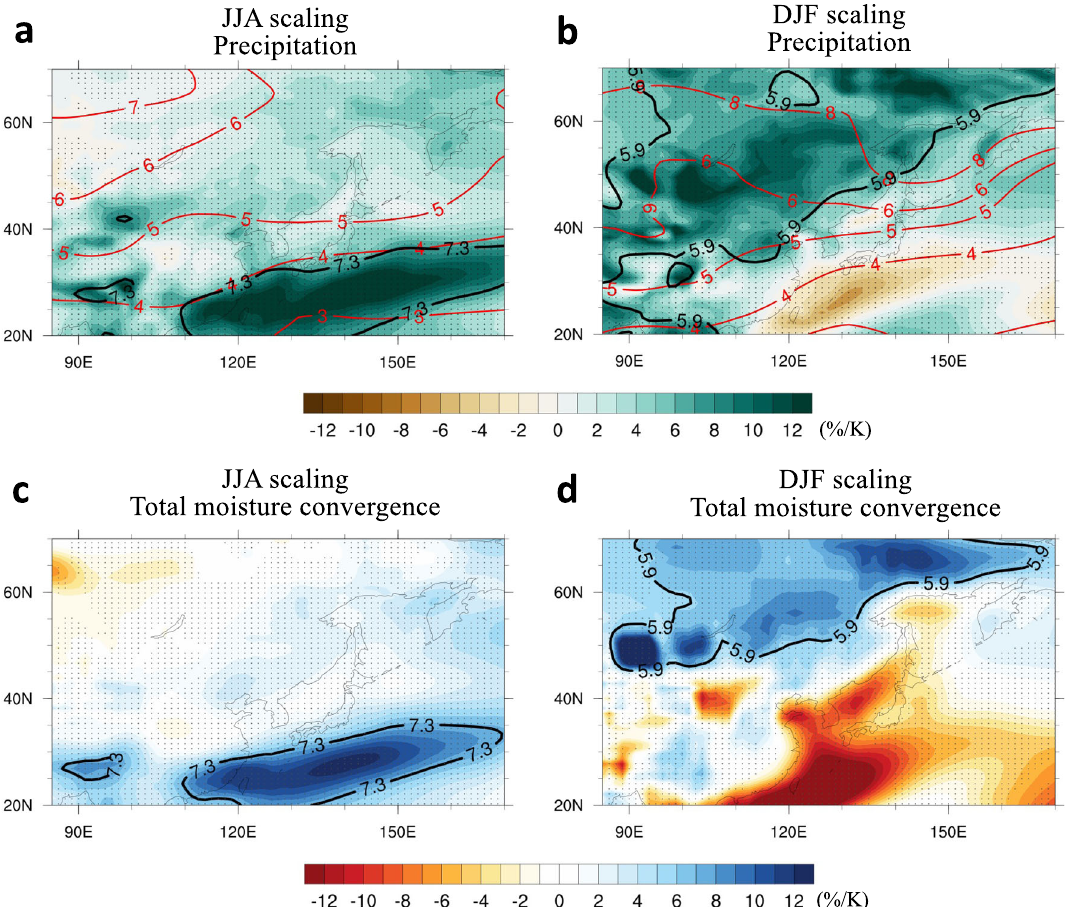
Fig. 1 Projected warming and scaling of precipitation with temperature. a , b Future changes of surface temperature in the CESM1-LES RCP8.5 simulations (red contours, unit in degrees K) and percentage change of precipitation scaled by unit temperature change (color shading, unit in %/K) in JJA and DJF. The changes are calculated as the differences between the two periods of 2070 – 2099 and 1975 – 2004. The thick black contour is the 7.3%/K scaling of atmospheric water vapor content in JJA. Stippling represents statistical signi fi cance at 5% level in student t test with respect to the 40 ensemble variances. c , d Same as above, but for the scaling of the total moisture fl ux divergence (convergence) in JJA and